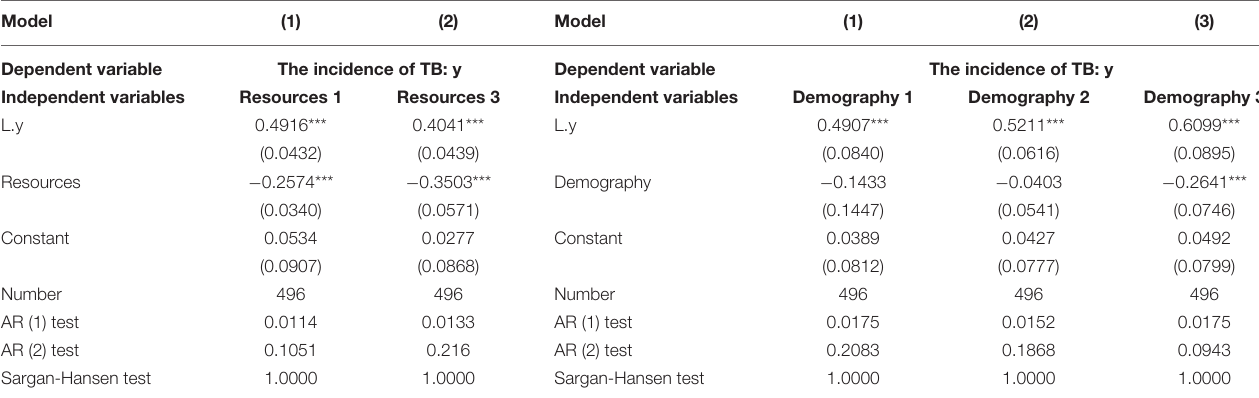
TABLE 5 | Estimated results of the impact of health resources and demographic variables on the incidence of